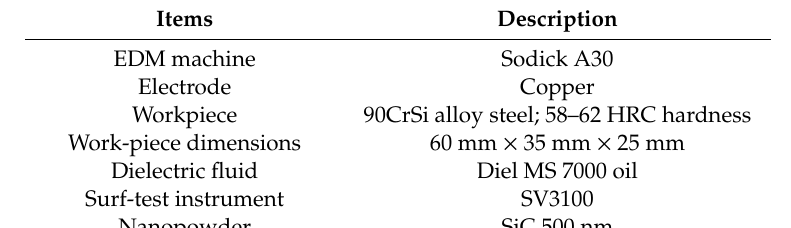
Figure 3. The electrode for PMEDM process. Table 3. PMEDM process information.